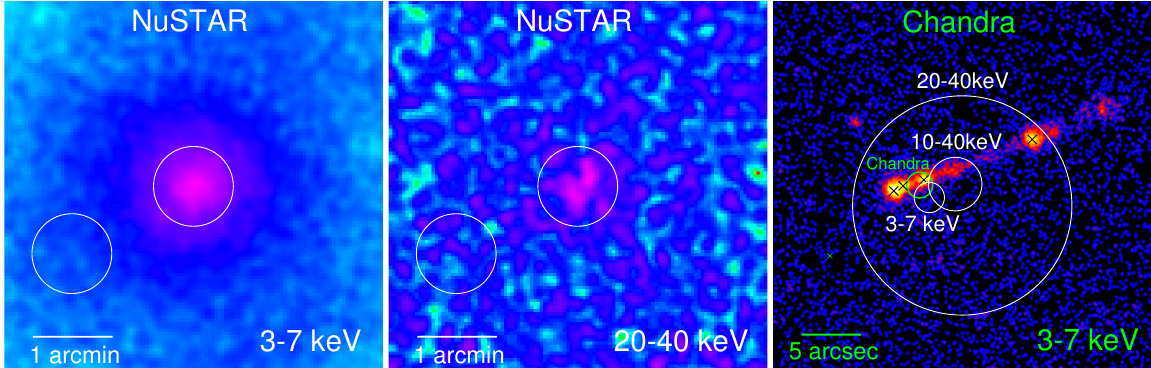
Figure 1. Smoothed NuSTAR images of M87 in the 3–7keV (left) and 20–40keV (middle) bands. The circles at the center and the lower left of the image indicate the spectral extraction regions of the source and the background, respectively. A high resolution Chandra image is shown in the right panel. The four crosses from the left to the right are the locations of the core, the HST -1 knot, knot D, and knot A, respectively. The three white solid circles indicate the 3 σ position errors of the emission peaks measured with NuSTAR in different energy bands. Note that the green circle indicates the peak location of the Chandra image in the 3–7keV band smoothed to the same spatial resolution as NuSTAR (FWHM = 18 (cid:48)(cid:48) ; smoothed Chandra image not shown). Although the Chandra core dominates the X-ray emission, the smoothed Chandra peak is shifted to the right from the core due to the X-ray contributions from the jet and the knots. Thus, the consistence of the peak positions in the soft and hard X-ray bands suggests that the spatial structure of the hard X-ray emission is consistent with that of the softer X-ray emission. These figures are modified from Wong et al.